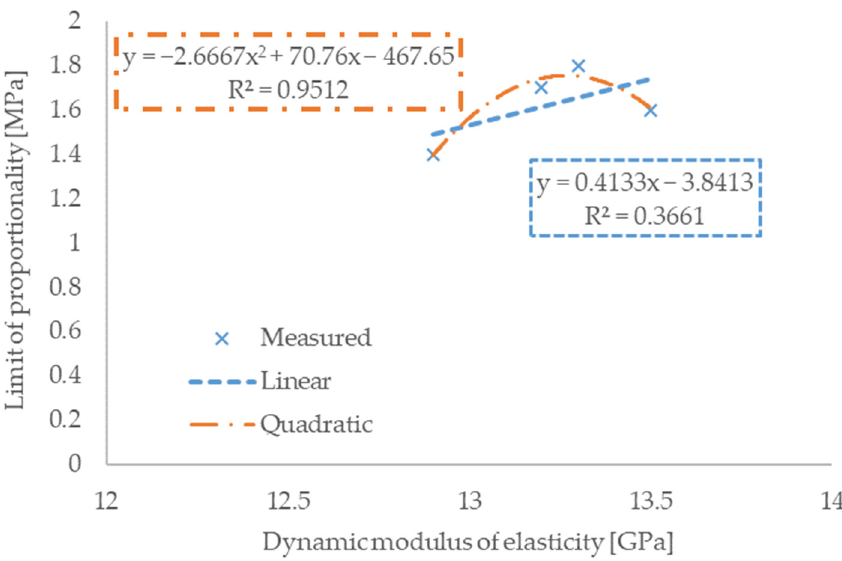
Figure 6. The relationship between dynamic modulus of elasticity and limit of proportionality.